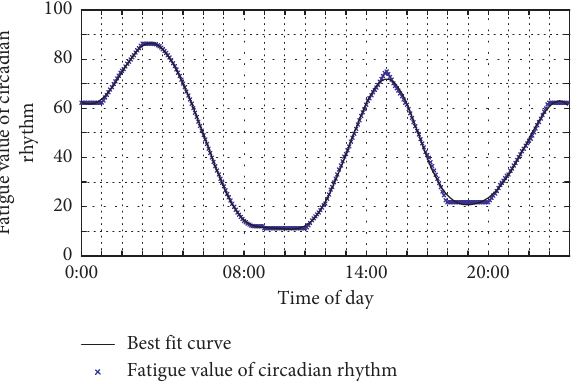
Figure 7: Fatigue value changes caused by the circadian rhythm.